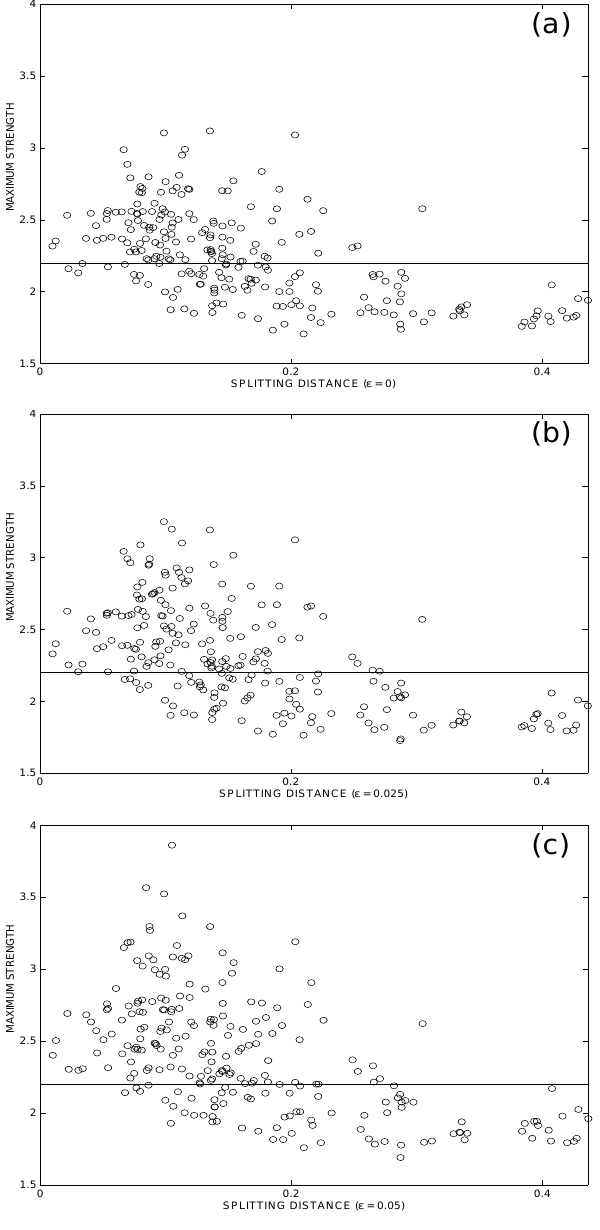
Fig. 18: Maximum strength versus the splitting distance δ(λ + ,λ − ) for a) the NLS equation and the HONLS equation with b) ǫ = 0 . 025 , and c) ǫ = 0 . 05 . the significant wave height, 2 . 2 H s , is given by the dashed curve. Figure 16b shows that when the nonlinear spectrum is near homoclinic data, U max exceeds 2 . 2 H s (a rogue wave develops at t ≈ 40). Figure 17b shows that when the nonlinear spectrum is far from homoclinic data, U max is significantly below 2 . 2 H s and a rogue wave does not develop. As a result we can correlate the occurrence of rogue waves characterized by JONSWAP spectrum with the proximity to homoclinic solutions of the NLS